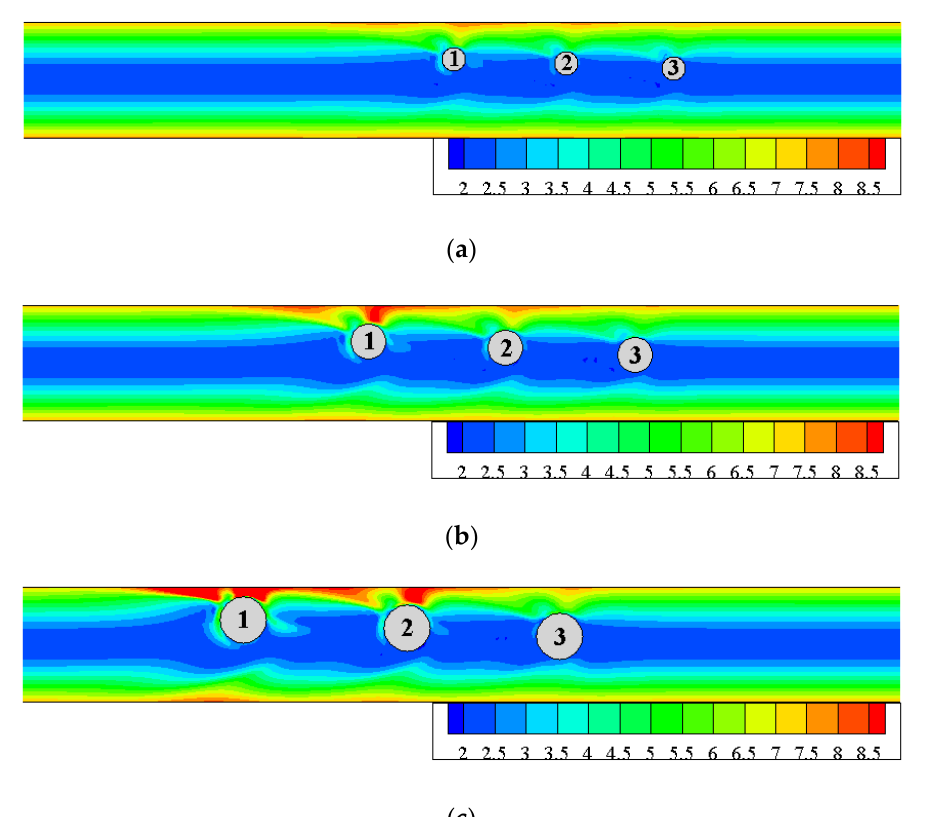
Figure 13. Polymer extension tr( B ) along the pathway in Giesekus fluid at t = 7 ( Wi = 0.5, η r = 0.3, α = 0.1, y 0 = 0.1, d 1,0 = d 2,0 = 0.5). ( a ) ε = 0.2; ( b ) ε = 0.3; ( c ) ε = 0.4.